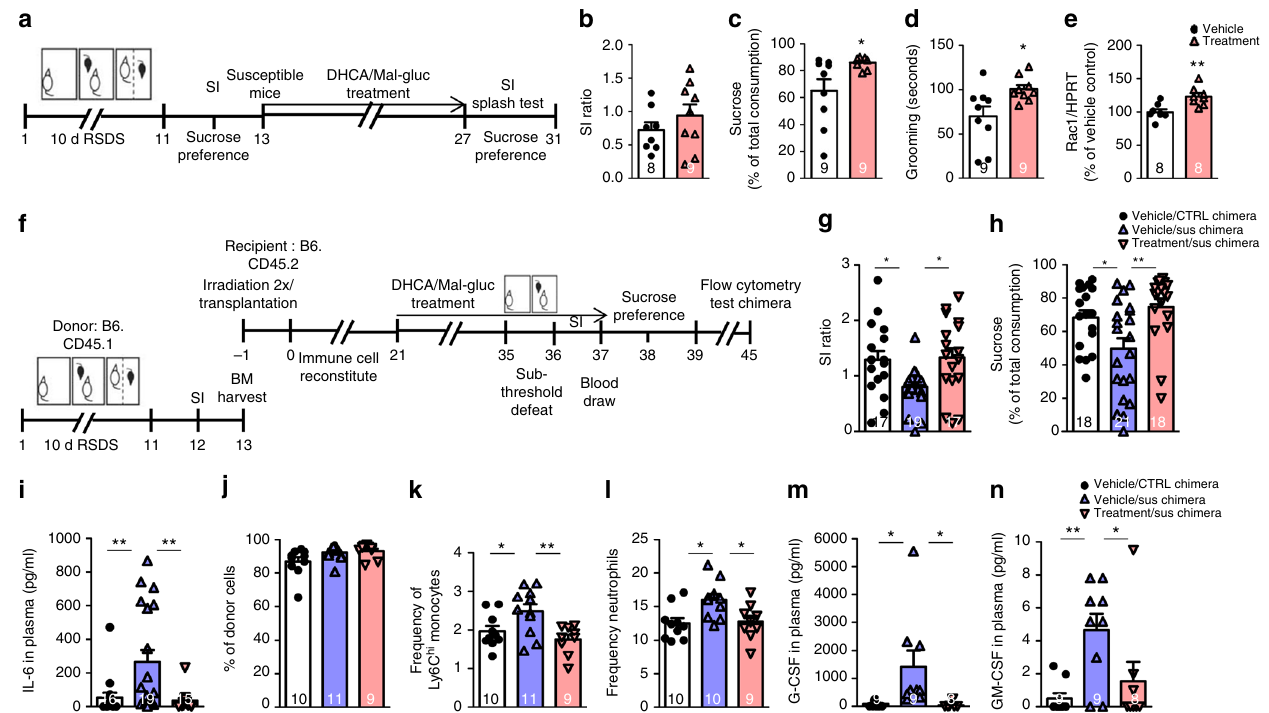
Fig. 5 Therapeutic effect of DHCA/Mal-gluc in treating stress-induced depression. a Schematic design of the experiment. b – d Behavioral tests in stress susceptible mice following 2 weeks vehicle or DHCA/Mal-gluc treatment. b Social avoidance behavioral test (two-tailed unpaired t -test, t 15 = 1.039, P = 0.3152). c Sucrose preference test (two-tailed unpaired t -test, t 16 = 2.406, P = 0.029) and d splash test (two-tailed unpaired t -test, t 16 = 2.539, P = 0.021). e Rac1 expression in the NAc (two-tailed unpaired t -test, t 14 = 3.637, P = 0.003). f Schematic design of the experiment. g , h Behavioral tests following sub-threshold defeat in BM chimeras with BM reconstructed from naive mice or susceptible mice with or without DHCA/Mal-gluc treatment. g Social avoidance test (one-way ANOVA, F 2,52 = 4.58, P = 0.015) and h sucrose preference test (one-way ANOVA, F 2,56 = 6.17, P = 0.004). i Plasma level of IL-6 24 h after the sub-threshold defeat (one-way ANOVA, F 2,49 = 6.98, P = 0.002). j – l DHCA/Mal-gluc treatment suppressed stress-induced increase of in fl ammatory Ly6C hi of monocytes and neutrophils in BM chimeras with BM reconstructed from susceptible mice. j Percentage of live leukocytes derived from the donor (one-way ANOVA, F 2,28 = 3.13, P = 0.144). k Frequency of Ly6C hi monocytes of donor origin. Numbers represent percentages of live leukocytes (one-way ANOVA, F 2,29 = 6.18, P = 0.006) and l frequency of neutrophils of donor origin. Numbers represent percentages of live leukocytes (one-way ANOVA, F 2,28 = 5.377, P = 0.011). m , n Plasma levels of G-CSF and GM-CSF 24 h after the sub-threshold defeat (one-way ANOVA, F 2,25 = 5.189, P = 0.0138 for G-CSF, F 2,25 = 6.103, P = 0.0075 for GM-CSF). All graphs represent mean ± s.e.m., * P < 0.05, ** P <